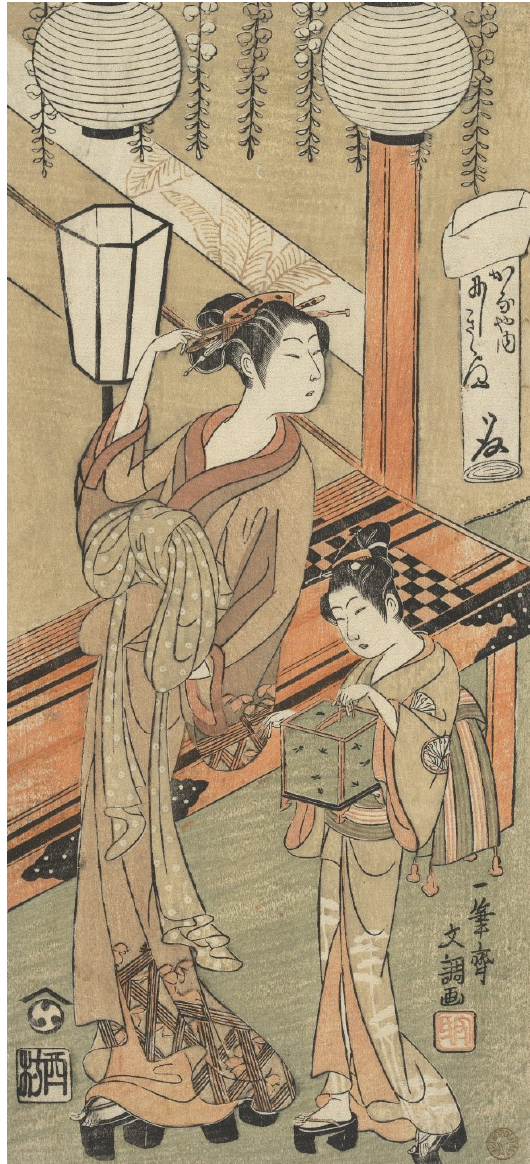
Figure 6. (T2). Courtesan and Attendant with a Cage of Fireflies. ca. 1770. Ippitsusai Bunchō (Japanese, active ca. 1765–1792). Woodblock print; ink and color on paper. Gift of Estate of Samuel Isham, 1914. Accession Number: JP907. The Metropolian Museum of Art, New York, NY, USA, www.metmuseum.org (accessed on 4 January 2022). Open access image, CC0.